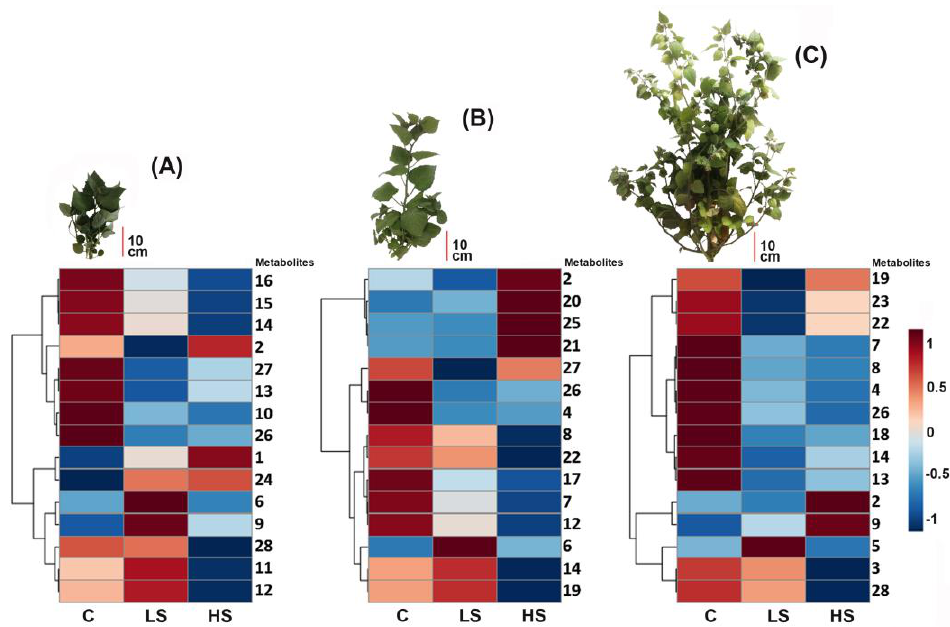
Figure 2. Distribution of the relative abundance of the most contrasting fifteen metabolites detected in extracts of P. peruviana aerial parts under salinity conditions, according to the sPLS-DA-derived variable influence on projection (VIP) scores (VIP > 1). This distribution is divided into three heat maps obtained from those profiles of plants at substages ( A ) 209 (vegetative), ( B ) 603 (flowering), and ( C ) 7003 (fruiting). Each heat map is organized by columns for each treatment: HS: high salinity (90 mM NaCl); LS: low salinity (30 mM NaCl); C: control (no NaCl treatment). Each color cell was associated with a normalized (scaled to unit variance, prior heatmap generation) relative abundance of each metabolite, located in the right side of each heatmap, depending on the color scale (dark red: high abundance; dark blue: low abundance). The most contrasting metabolites per growth substage are organized according to the Ward clustering algorithm measuring Euclidean distance, and num- bered according to the annotated metabolite list presented in Table A2.